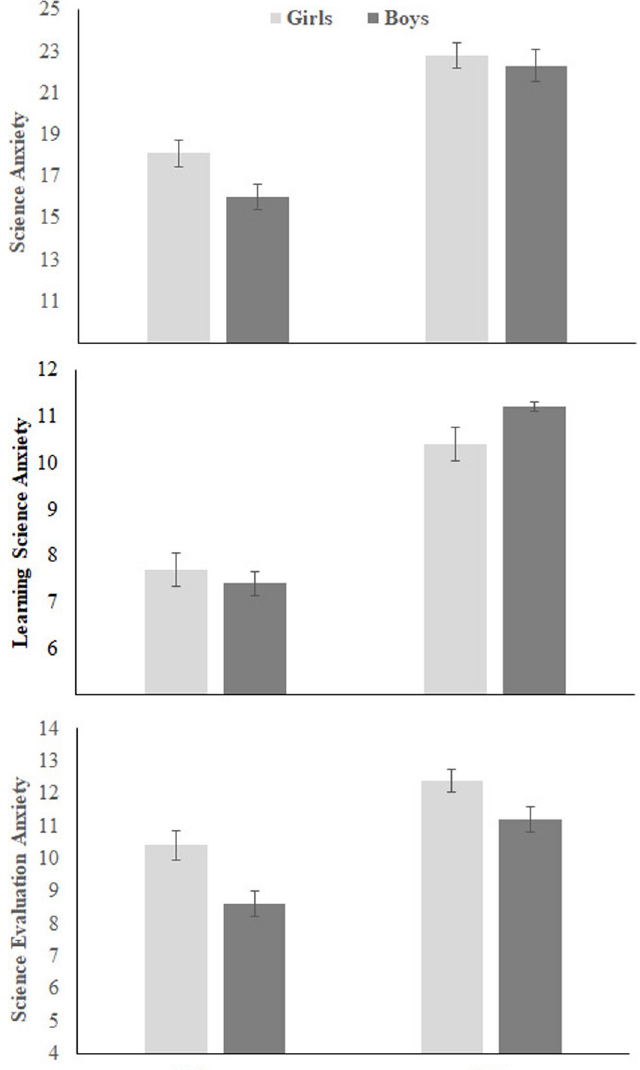
Fig 6. Gender and track differences in science anxiety in Study 2. The horizontal axis represents the science and arts tracks.